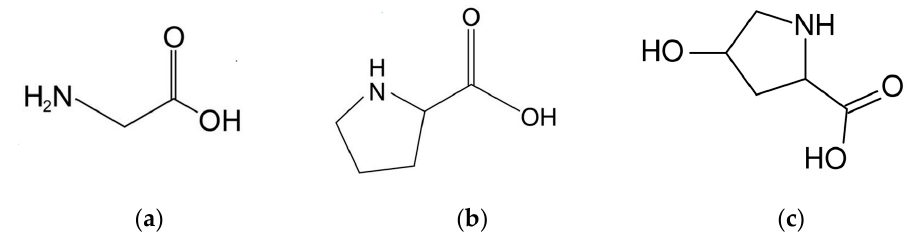
Figure 1. Schematic model of glycine ( a ), proline ( b ) and hydroxyproline ( c ). Other amino acids residues, such as alanine, lysosine and tyrosine, may occur in the X or Y locations of the polypeptide chain. In the α -chain of fibrous collagen, about 25% of amino acids are proline and hydroxyproline. They stabilize the triple-helical structure and effectively block internal rotations of collagen chains at these sites [33]. Moreover, hydroxyproline is an important amino acid in maintaining thermal stability of collagen molecules [34,35]. The most common secondary structure in collagen type I is the α -helix forming a triple helix along with the β -sheet and irregular conformation [36,37]. The triple helix structure is upheld mainly by hydrogen bonds between the glycine - NH group and carbonyl group C=O of residues of another polypeptide chains. Additionally, the triple helix’s stability is due to hydrogen bonds between the C α H group from glycine and C=O and hydrogen bonds with water